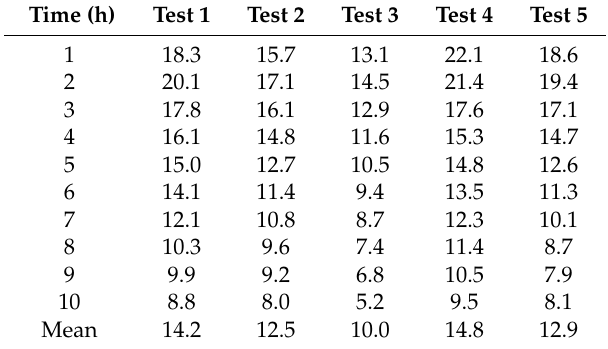
Table 4. The temperature rise of the solid desiccant modules for five tests ( ◦